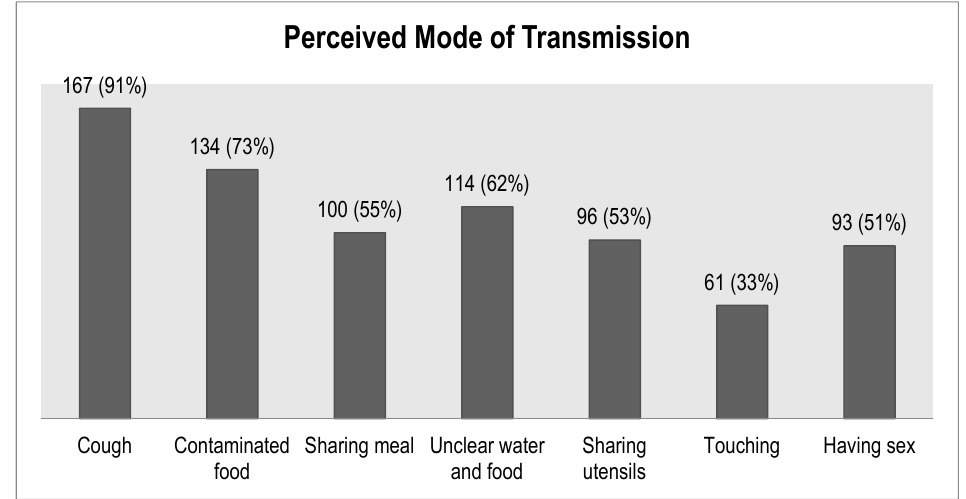
Figure 3. Community perception about probable mode of tuberculosis (TB) transmission. Table 3. Knowledge about TB among community members.